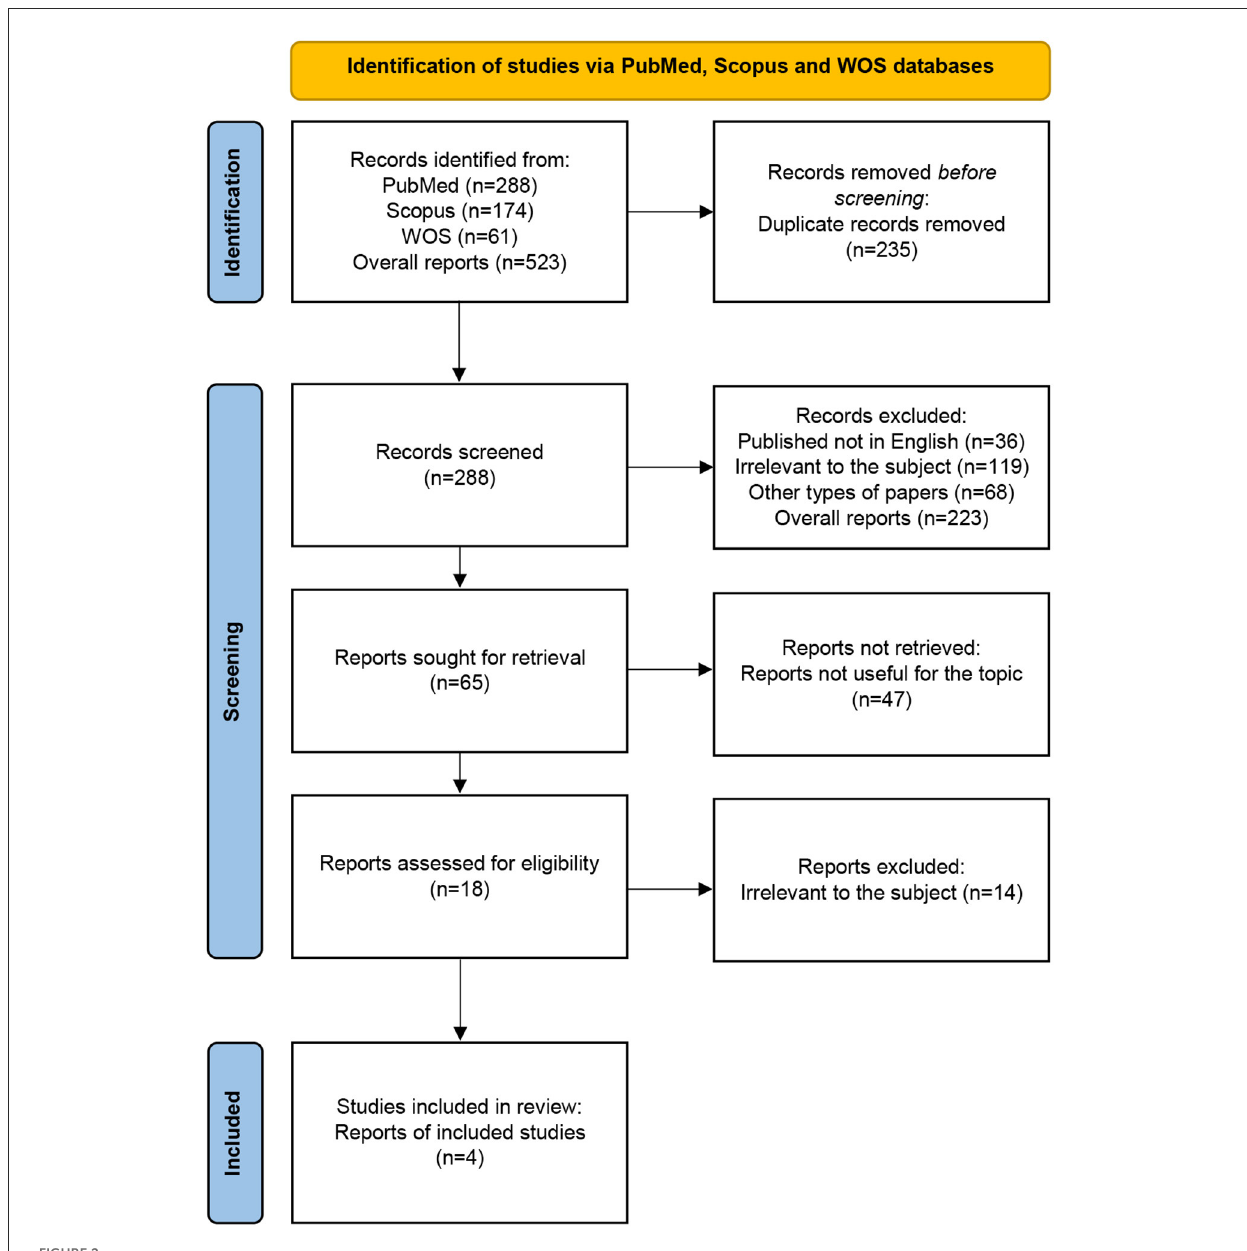
FIGURE2 PRISMA flow diagram: systematic review methodology. WOS, Web of Science Core